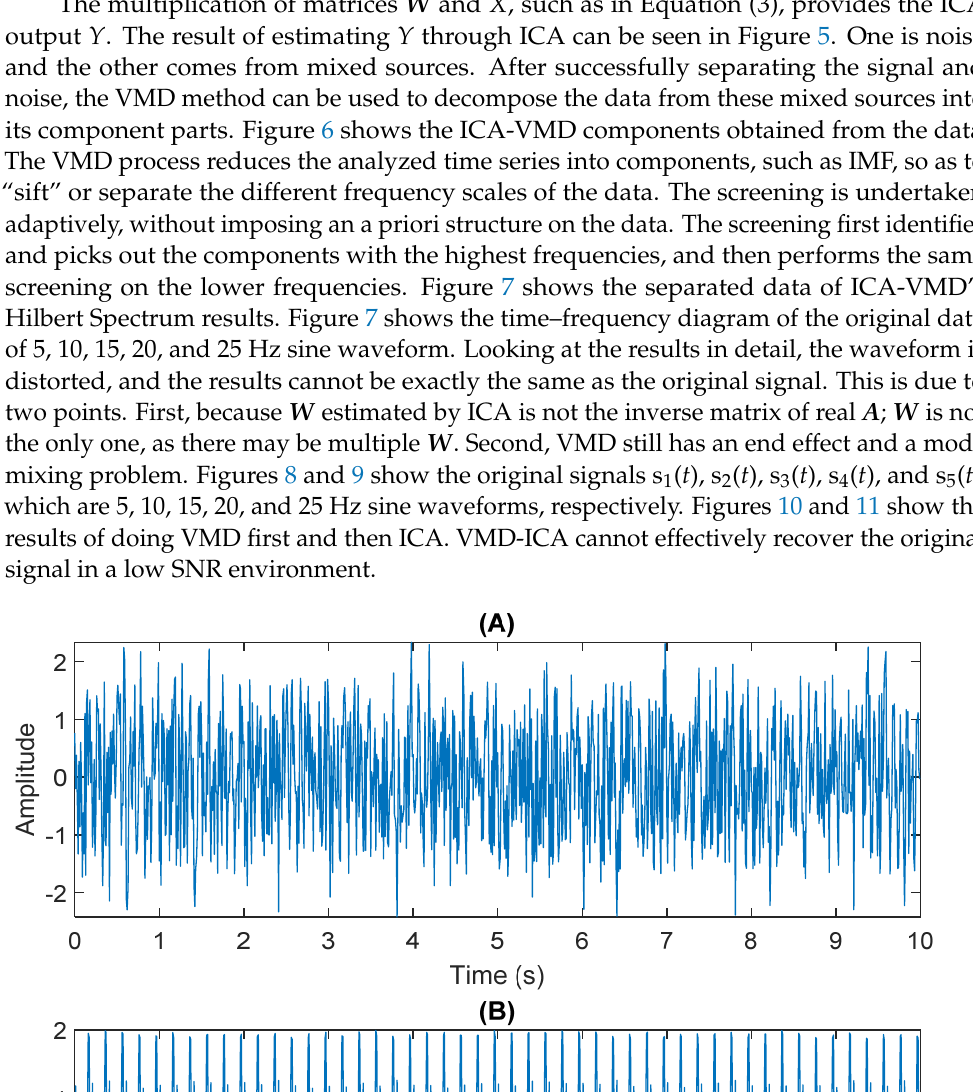
Figure 5. Analysis of data separated by ICA: ( A ) white Gaussian noise; ( B ) mixed sources.